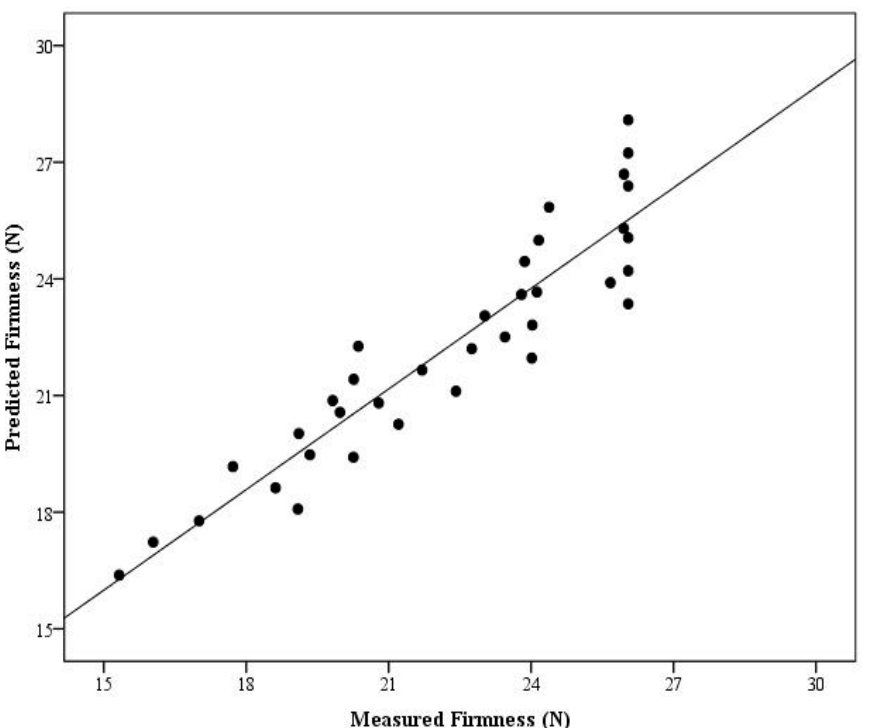
Figure 7. Results for the prediction of firmness values based on the linear regression models.